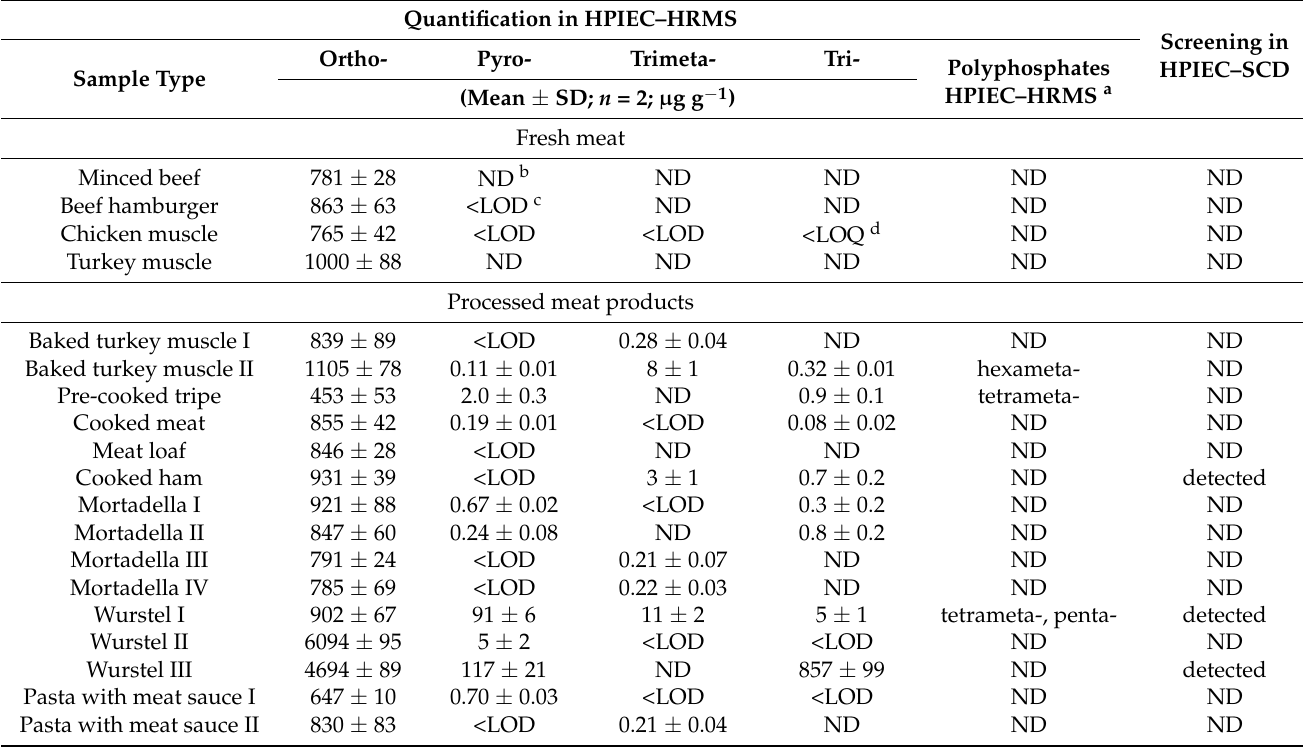
Table 3. (Poly)phosphates in different types of undeclared meat/meat